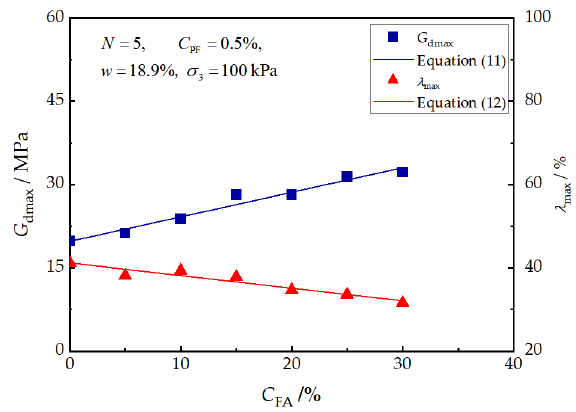
G and λ . Figure 11. Effects of fly ash content on Figure 11. Effects of fly ash content on G dmax and λ max max dmax Figure 12 shows the effects of PF on the G and λ of reinforced loess. Gener- max dmax ally, the effects of the PF content were found to not be significant in comparison to other factors. When the PF content increased from 0.0% to 1.0%, G first experienced a mod- dmax erate increase, and thereafter, it decreased slightly, while λ increased almost linearly max with the PF content. A quadratic polynomial and a linear model were proposed, respec- tively, for G and dmax